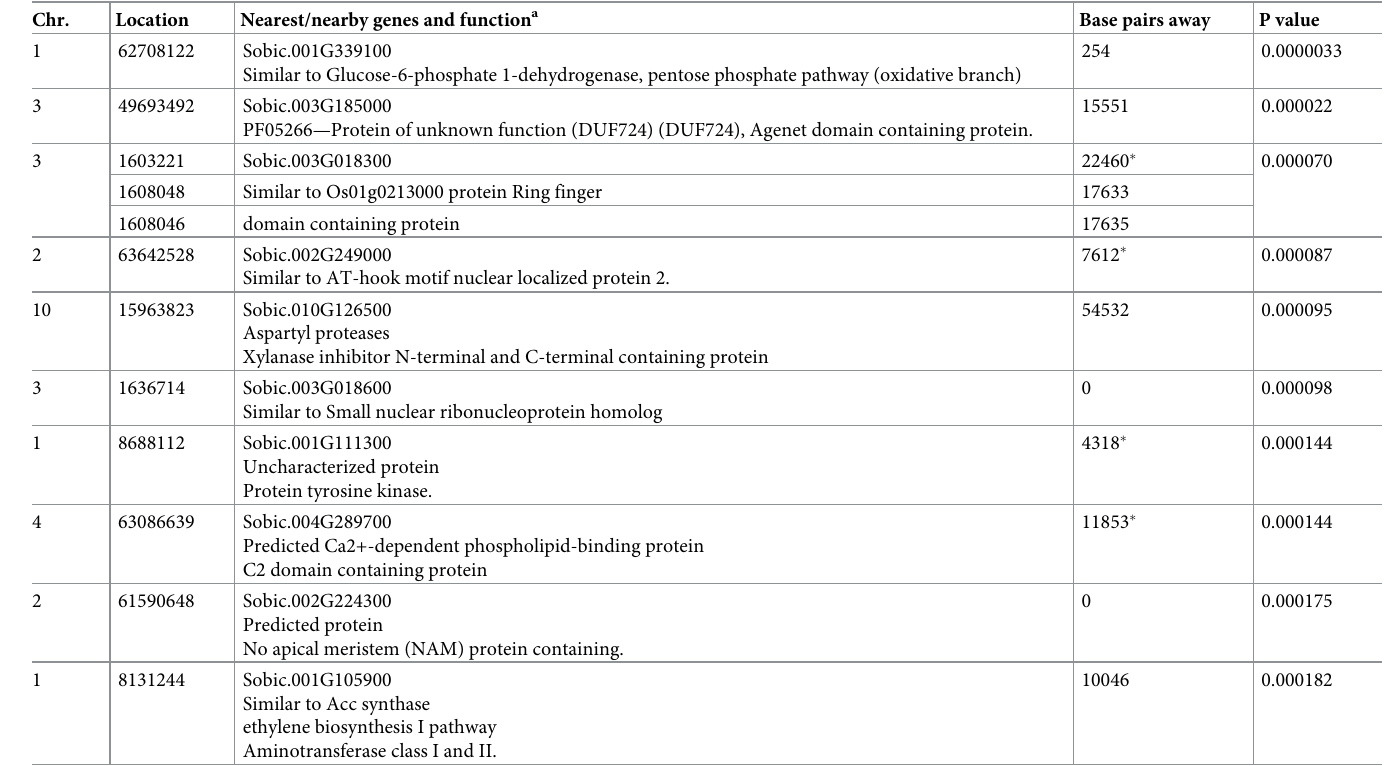
Table 2. Top SNPs associated with downy mildew.